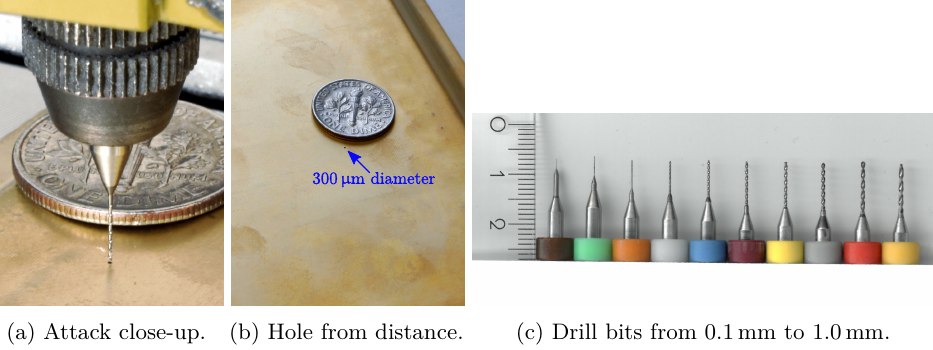
Figure 16: Exemplary attack on cover with 300 µ m drill and a US dime as reference showcasing the disproportion of attack size to overall size of